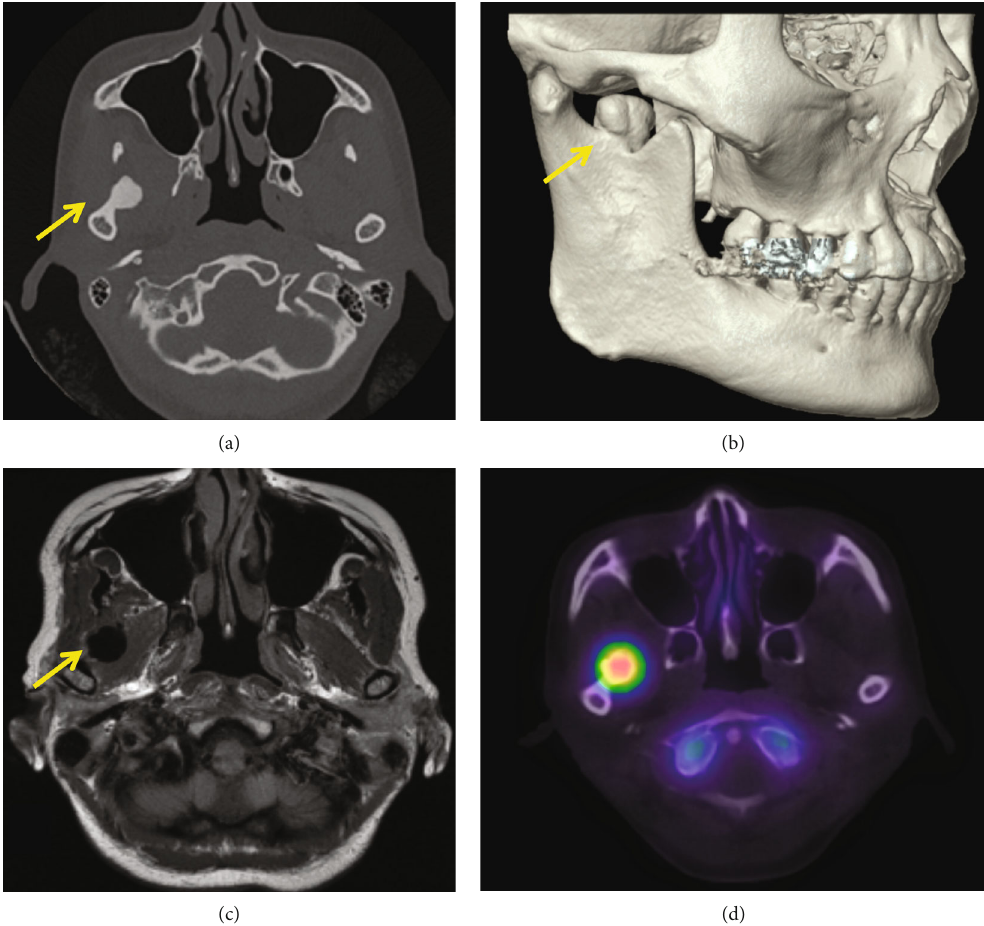
Figure 2: Preoperative examination. (a) Computed tomography showed a 13.3 × 12.8 × 10.0mm sized lesion showing Houns fi eld units (HU) equivalent to that of the mandible, arising from the right mandibular notch. The CT values of osteoma ranged from 1480 to 1580 HU. (b) 3D-CT showed osteoma was found in the right mandibular notch. (c) Magnetic resonance imaging showed uniform hypointense trabecular bone, and there was no continuity of fat signals in the bone marrow, suggesting exclusion of the lateral pterygoid muscle because of bone lesions. (d) Radioisotope imaging showed signi fi cant uptake of Tc-99m by the osteoma in the right mandibular notch.